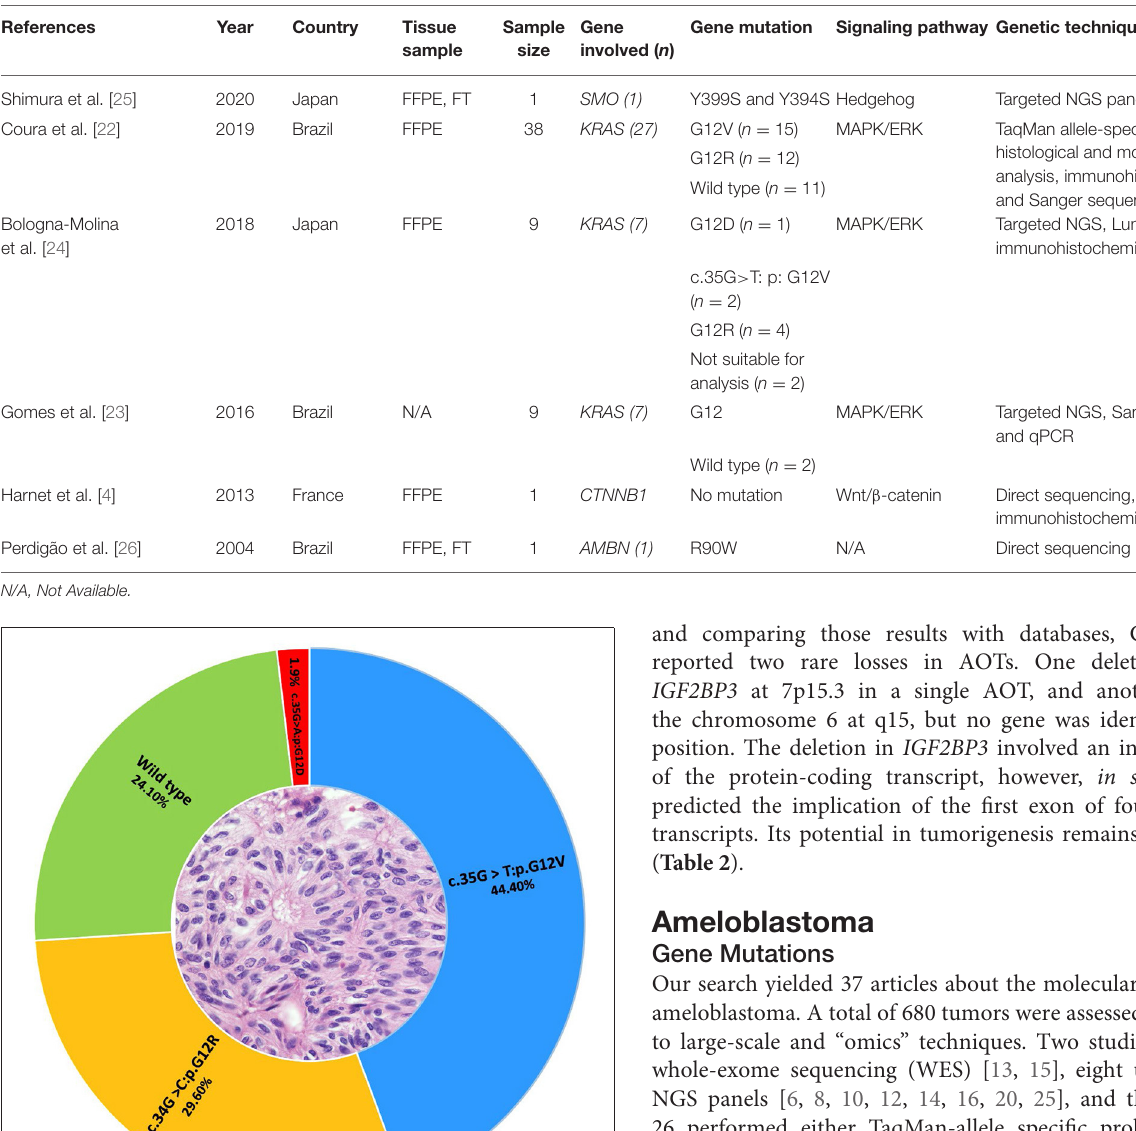
TABLE 1 | Gene mutations reported in AOT.